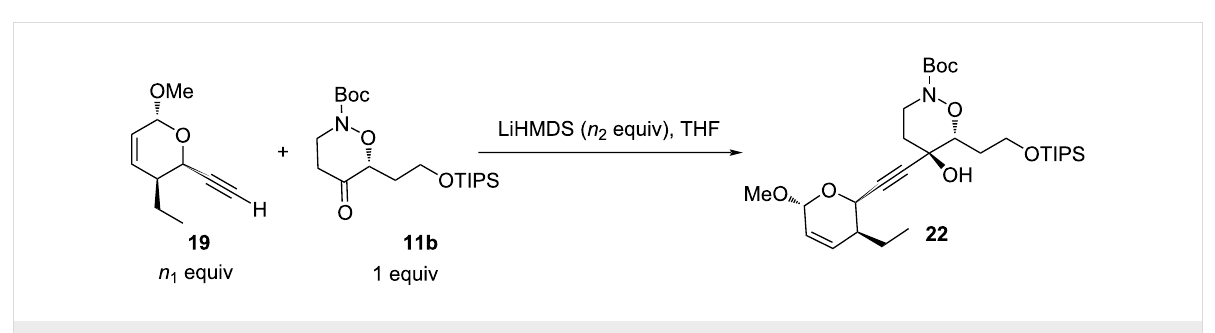
Scheme 7: Coupling reaction between alkyne 19 and ketone 11b .